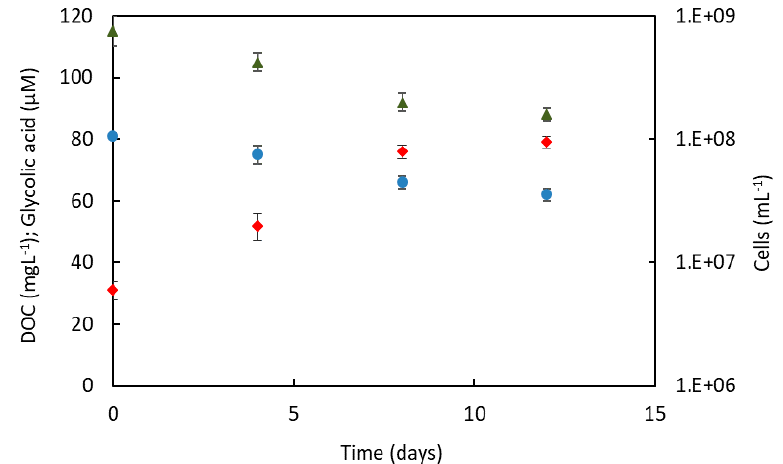
Figure 2. Growth of C. ammoniigenes IT2 on spent A. ferrooxidans medium. ( (cid:7) ) number of cells; ( • ) dissolved organic carbon; ( (cid:78) ); glycolic acid. The symbols indicate means for duplicate cultures, and error bars indicate